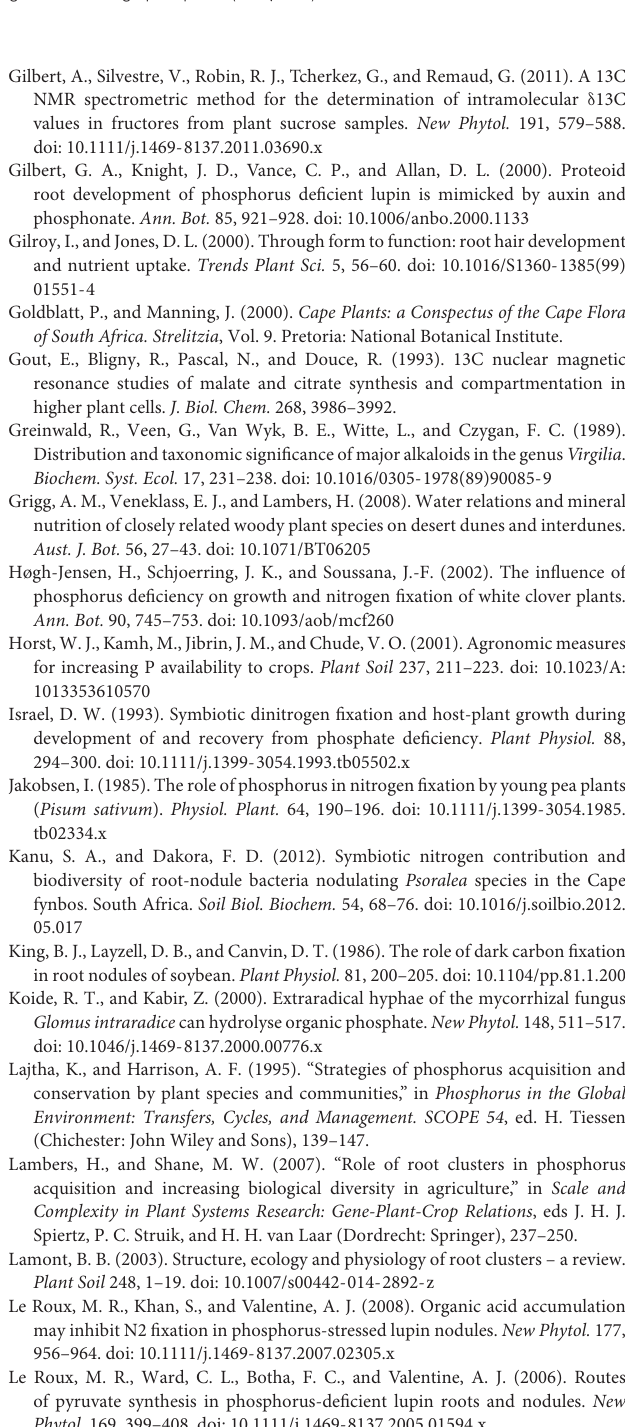
FIGURE S1 | A section of the 13 C spectra for (a) roots after 1 h, (b) roots after 2 h grown under high phosphate (500 µ M P) conditions of V. divaricata. FIGURE S2 | A section of the 13 C spectra of (a) roots after 1 h, (b) roots after 2 h grown under low phosphate (5 µ M P) conditions of V. divaricata. FIGURE S3 | A section of the 13 C spectra of (a) nodules after 1 h, (b) nodules after 2 h grown under high phosphate (500 µ M P) conditions of V. divaricata.